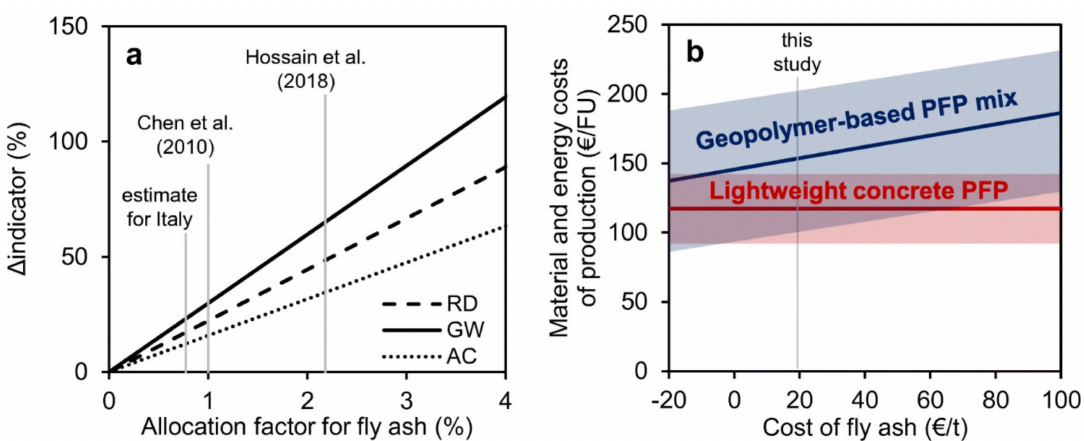
Figure 21. ( a ) Variation of the main environmental indicators for the geopolymer-based PFP mixture as a function of allocation of the coal life cycle impacts to the fly ash. ( b ) Estimated material and energy costs for the geopolymer-based mixture and for the lightweight concrete alternative as a function of the cost of fly ash. Reprinted from [87], © 2020 with permission from Springer